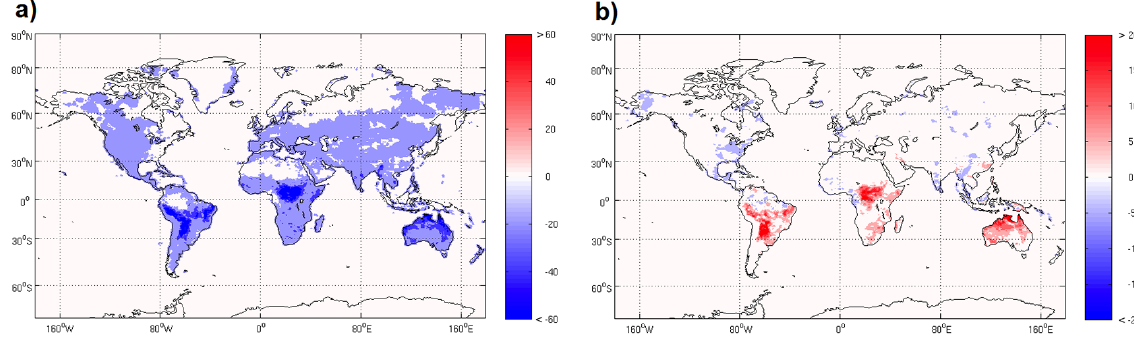
Figure 9. Difference in isoprene annual mean emissions (mgm − 2 day − 1 ) between the sensitivity S4 (soil moisture effect) and the reference (left), and between the sensitivity run S5 (sensitivity to PAR) and the reference (right) for the year 2003. Table 4. Inventories used in the comparison together with applied model system and driving input data. (RF99 = Ramankutty and Foley, 1999, M08 = Müller et al., 2008, S14 = Stavrakou et al., 2014, A07 = Arneth et al., 2007a, G06 = Guenther et al., 2006). Data set Model Weather LAI PFT Emission Data Reference potentials (cid:15) availability MEGAN–MACC MEGANv2.1 MERRA MODIS CLM4 This study BISA-bottom-up ECMWF MODIS BISA-top-down ECMWF GUESS-ES LPJ-GUESS CRU LPJV LPJV LPJ-GUESS NCEP